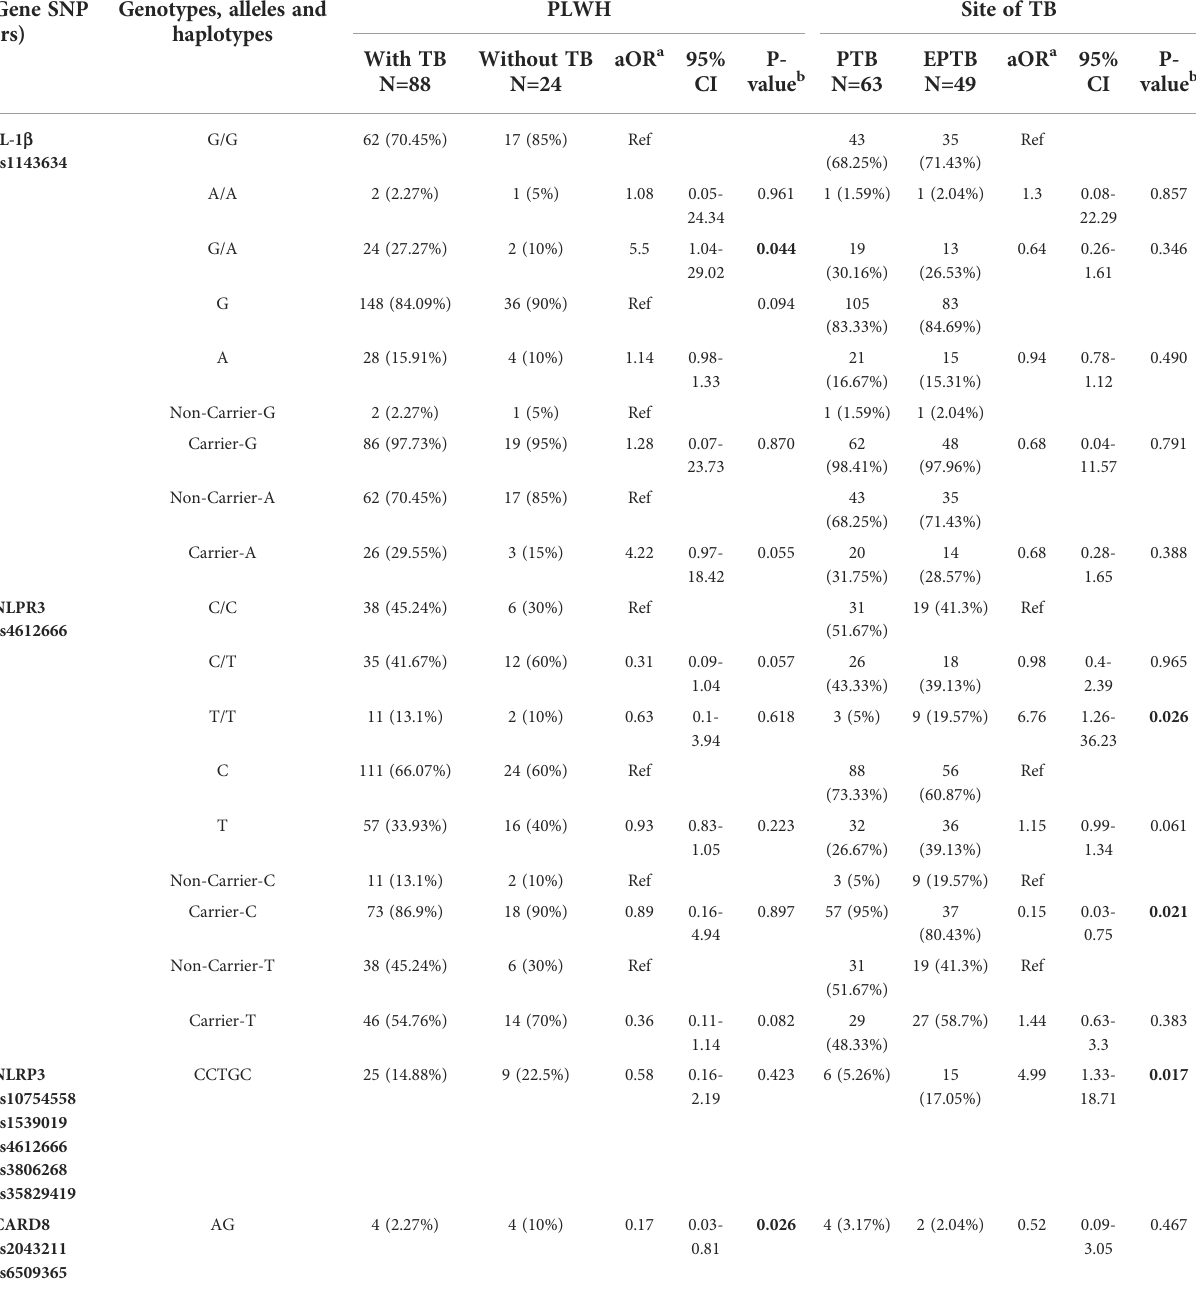
TABLE 2 Unconditional logistic multiple regression model of risk and protection factors for TB and for distinct TB clinical presentations according to selected in fl ammasome SNP genetic pro fi